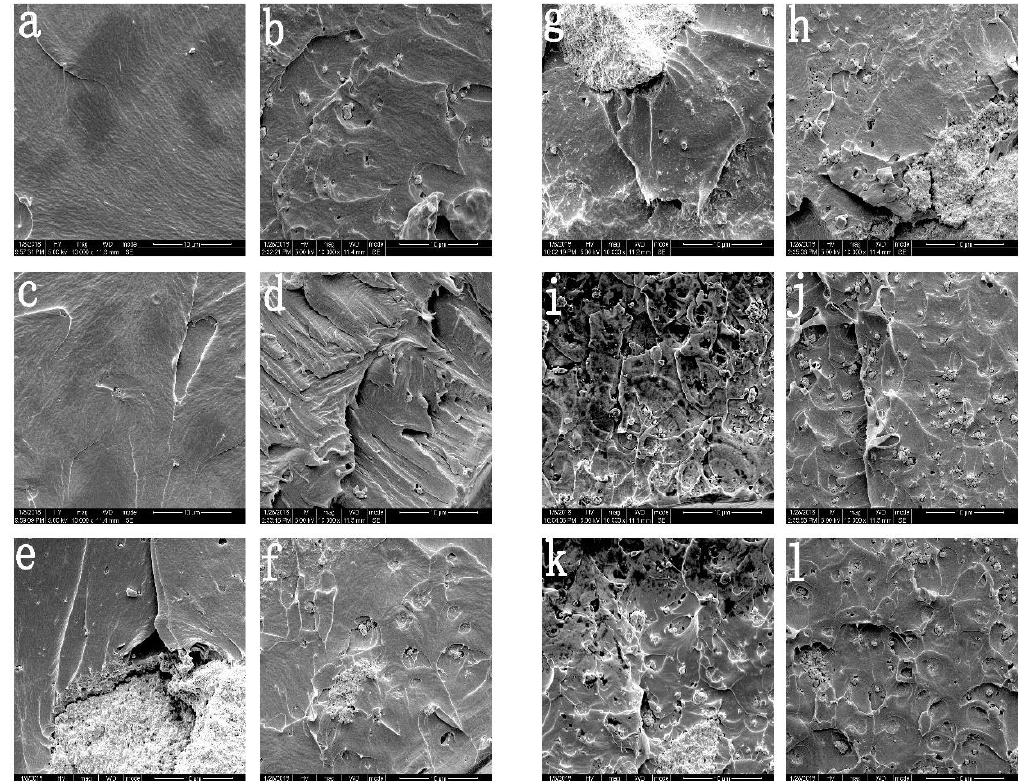
Figure 2. ( a , c , e , g , i , k ) represents the microstructure morphology of composite film PLA-0, PLA-1%, PLA-5%, PLA-10%, PLA-15% and PLA-20% before high pressure treatment, respectively (mag:10,000×); ( b , d , f , h , j , l ) represents the microstructure morphology of composite film PLA-0, PLA-1%, PLA-5%, PLA-10%, PLA-15% and PLA-20% after high pressure treatment, respectively (mag:10,000×).